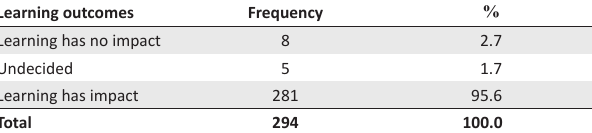
TABLE 8: Overall youth farm entrepreneurial